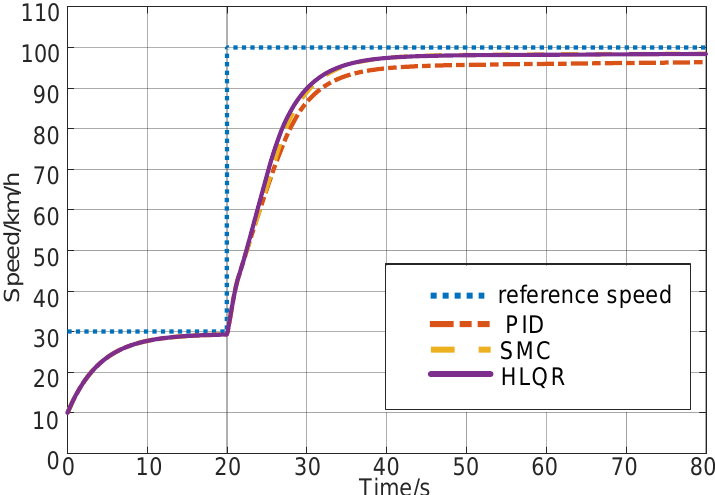
Figure 5. Vehicle speed on the changed road surface controlled by PID/SMC and